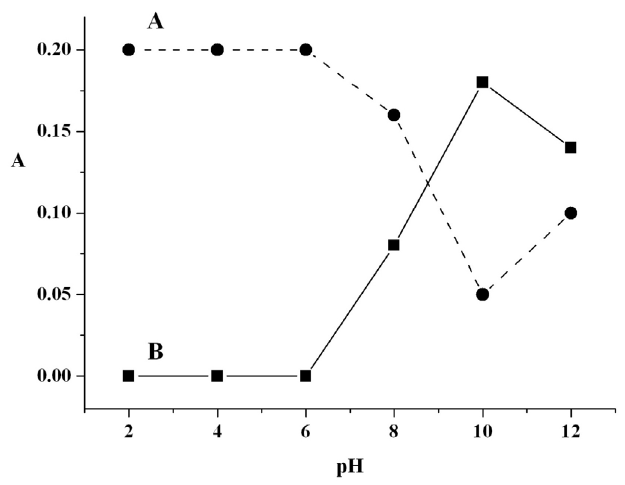
FIGURE 3 - Plots of absorbance vs pH of the indigo carmine solution (1x10 -5 mol L -1 ) at 615 nm ( A ) and complex (Cu(II) = 1x10 -4 mol L -1 ) generated at 715 nm ( B ).